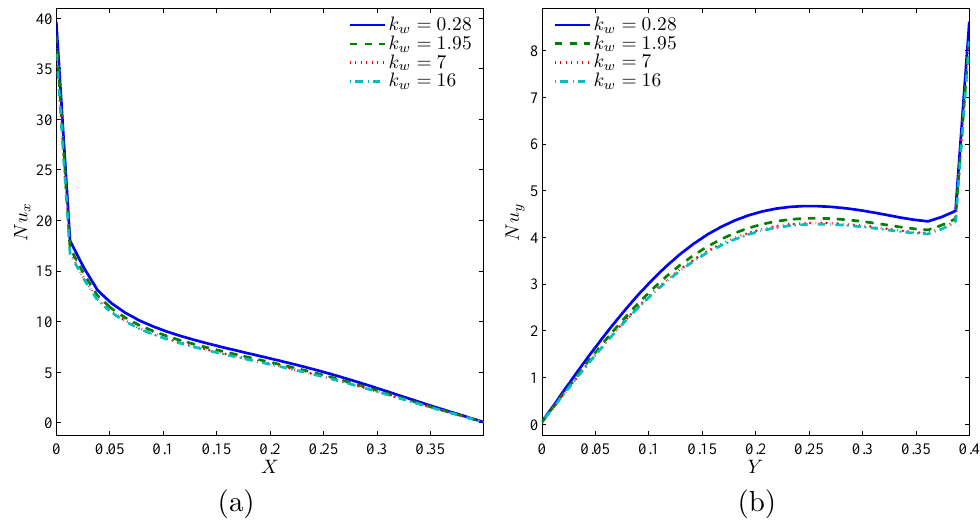
Figure 12. Variations of the local Nusselt numbers along ( a ) the bottom side wall ( X ) and ( b ) the left side wall ( Y ) for different k w at Ra = 10 5 , φ = 0.02 and D = 0.3.